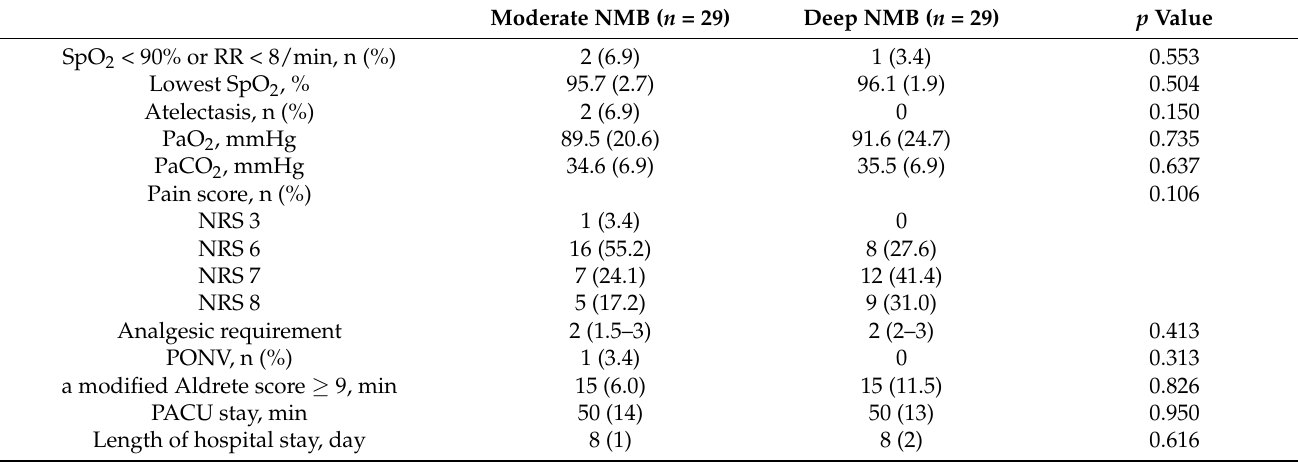
Table 3. Postoperative